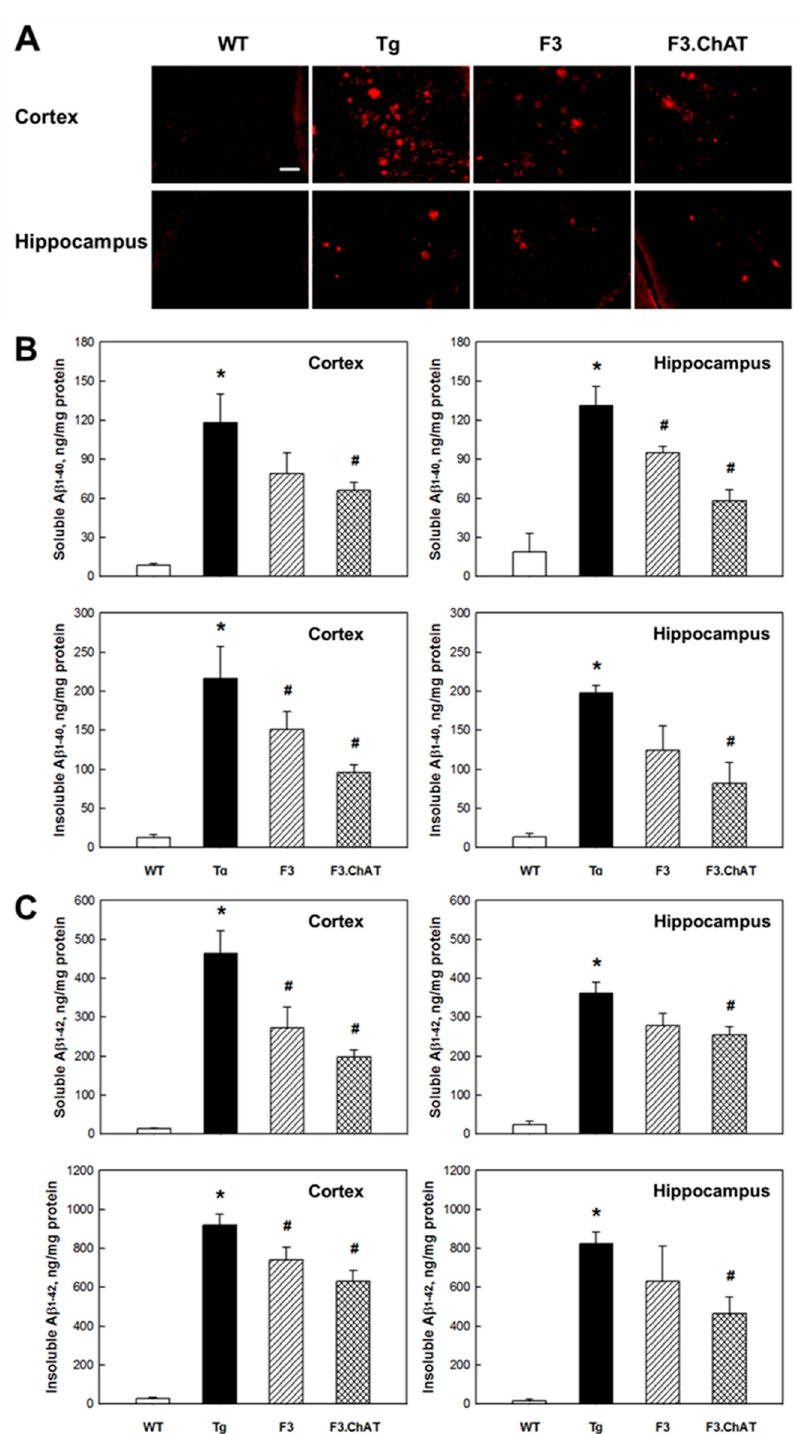
Figure 4. Amyloid β deposit and plaque formation in the brain of wild-type (WT) and APPswe / PS1dE9 transgenic (Tg) mice transplanted with F3 or F3.ChAT neural stem cells. ( A ): A β (senile) plaques in the cortex and hippocampus. ( B , C ): Concentration of soluble and insoluble A β 1-40 ( B ) and A β 1-42 ( C ) peptides in the cortex and hippocampus of WT and Tg mice. Bar = 20 µ m. * Significantly di ff erent from WT mice ( p < 0.05). # Significantly di ff erent from Tg mice ( p < 0.05).